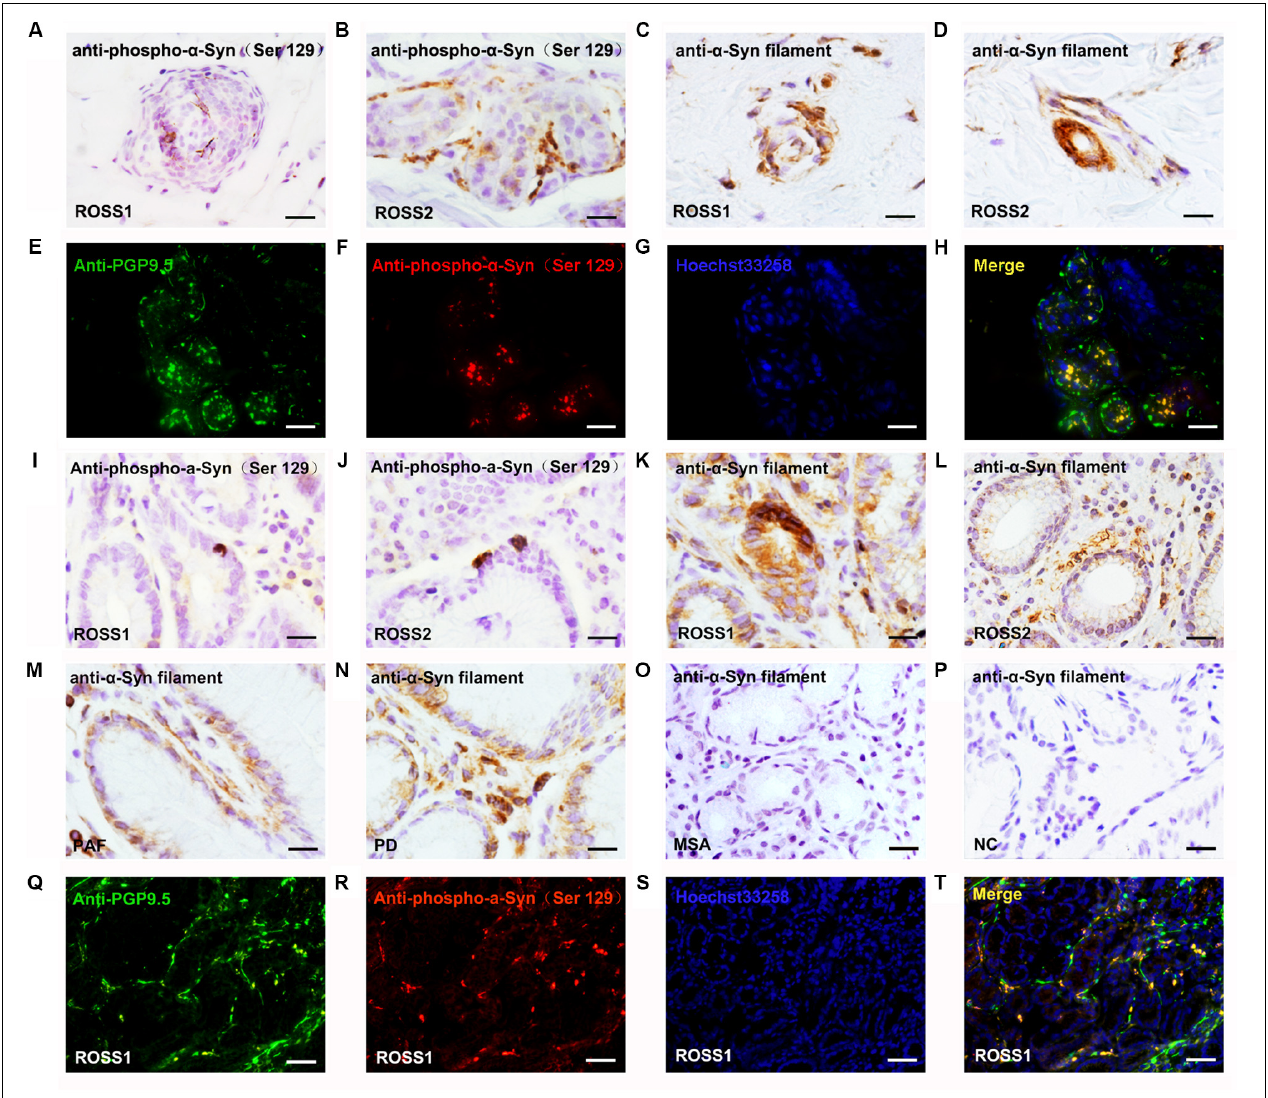
FIGURE 2 | Pathological α -Syn immunoreactivity in patients with Ross syndrome, PAF PD, MSA, and normal controls. (A–D,I–P) Some of fibers were positive for p α -Syn inclusions (A,B,I,J) or α -Syn filament (C,D,K,L) in anhidrotic skin (A–D) and lesser curvature of stomach (I–L) . (M–P) α -Syn filament was present in lesser curvature of stomach in PAF (M) and PD (N) , but not in MSA (O) and normal controls (P) . (E–H,Q–T) Double immunofluorescence analysis showed that p α -Syn colocalized with panaxonal marker PGP 9.5 in the skin (E–H) and lesser curvature of stomach (Q–T) from the patients with RS. Bar = 100 µ m.